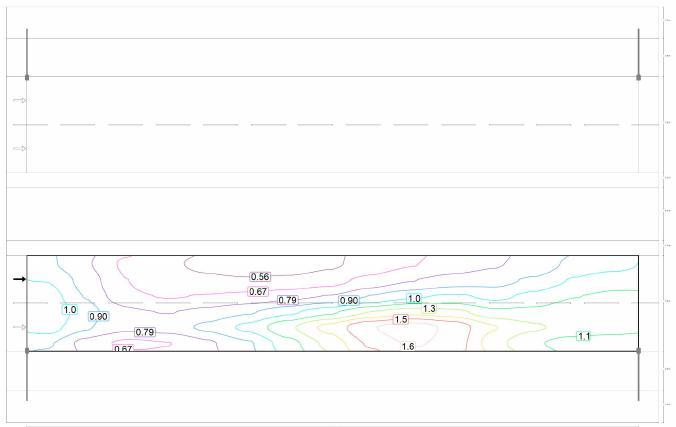
Figure 6. Jasper LED 120 W 13500 lm luminance for selected lamps in cd/m 2 units. Value chart and plan with projection of lighting distribution (source: original work).